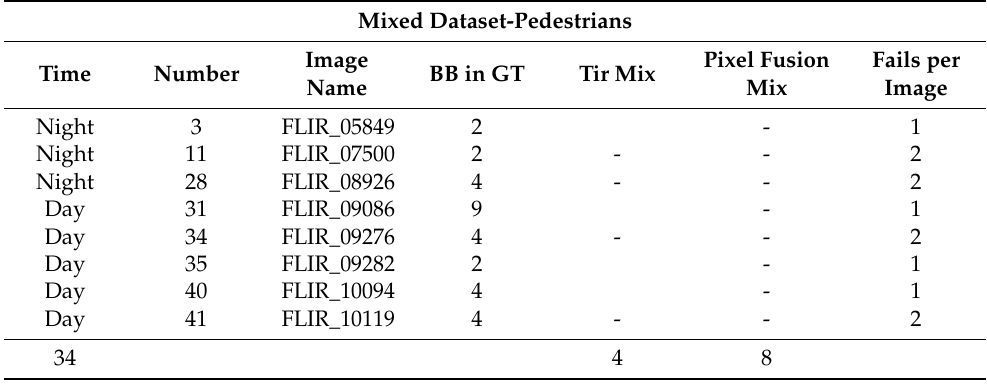
Table A8. Networks trained with mixed datasets failed to classify 4–8 images for pedestrian objects out of 34 day and night test